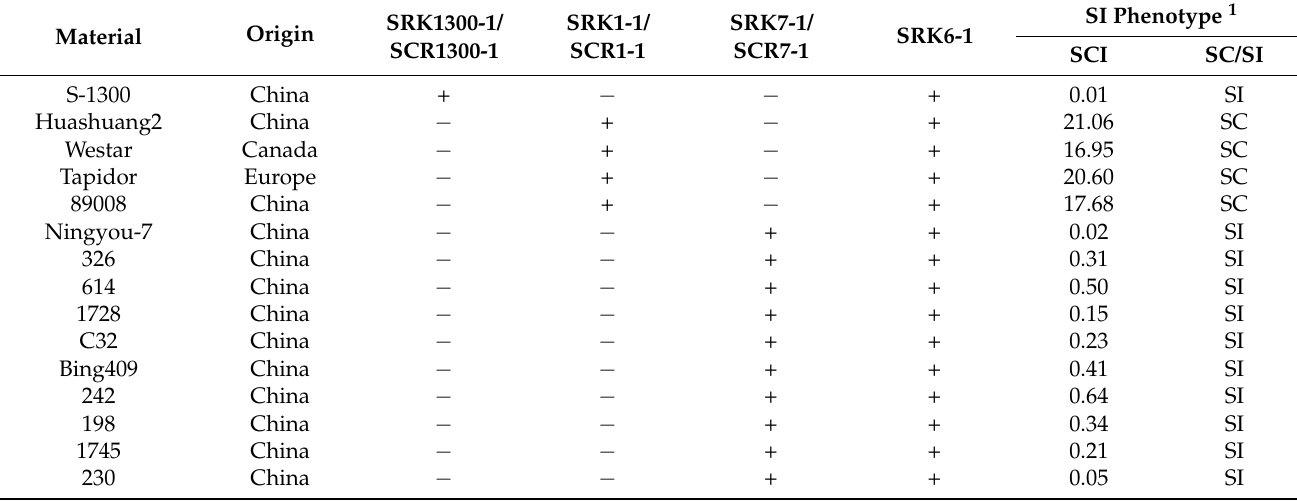
Table 1. Genotypes of the 14 B. napus lines collected and the phenotypes of the corresponding F 1 hybrids. Material